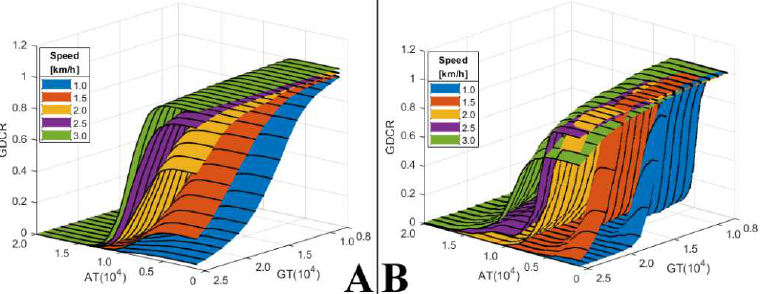
Figure 7. Experimental results of actual GDC test. ( A ) The GDCR of the Non-PD group. ( B ) The GDCR of the PD group.